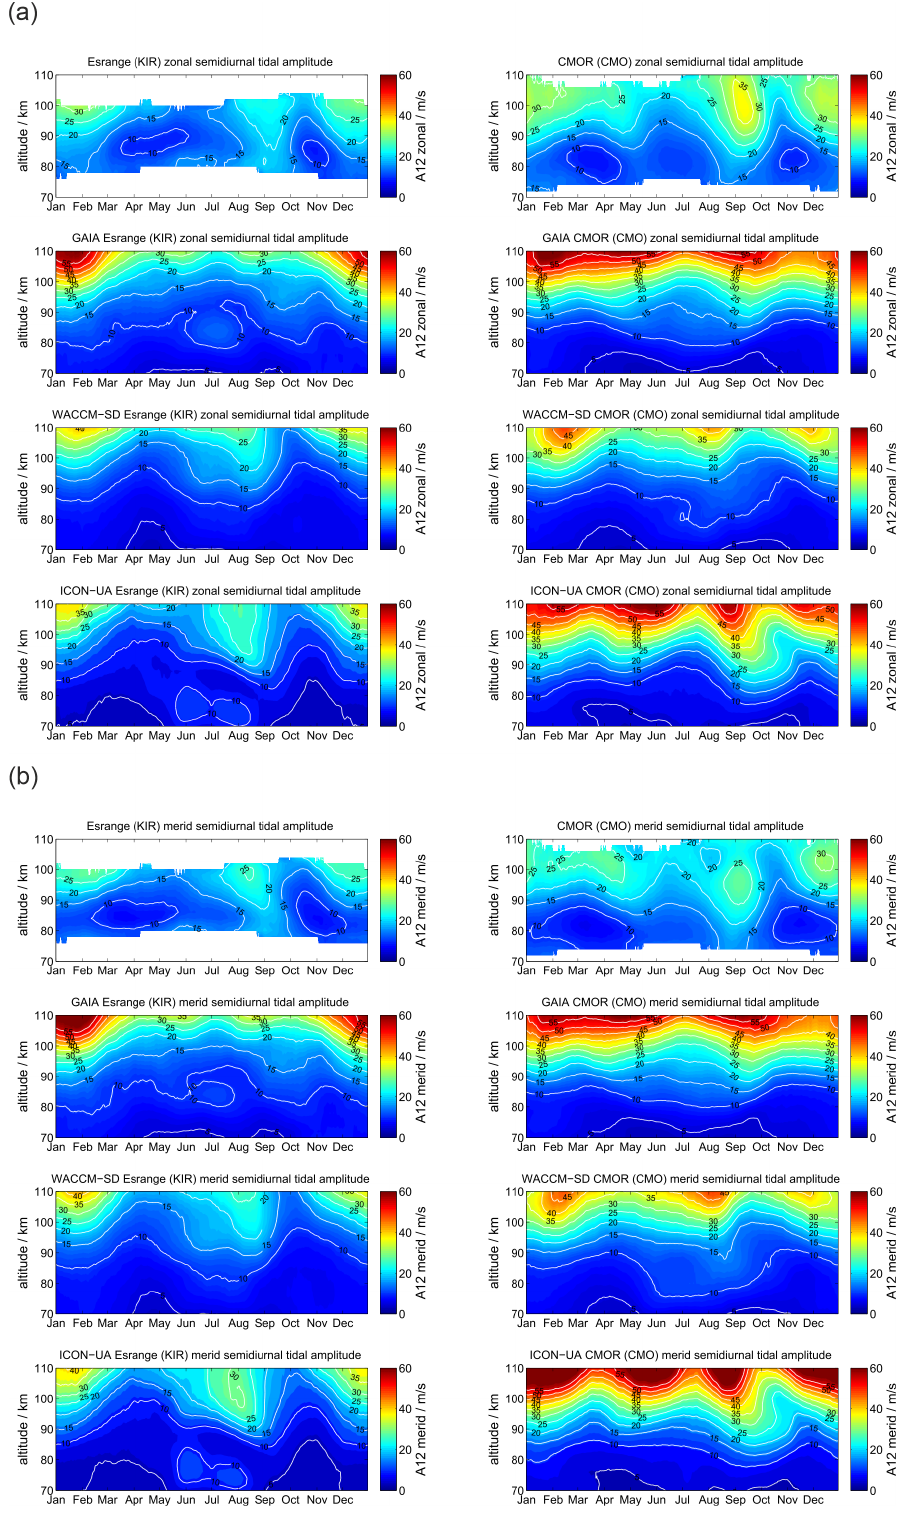
Figure A5. The same as Fig. 2, but for the semidiurnal tidal amplitudes above KIR and CMO.